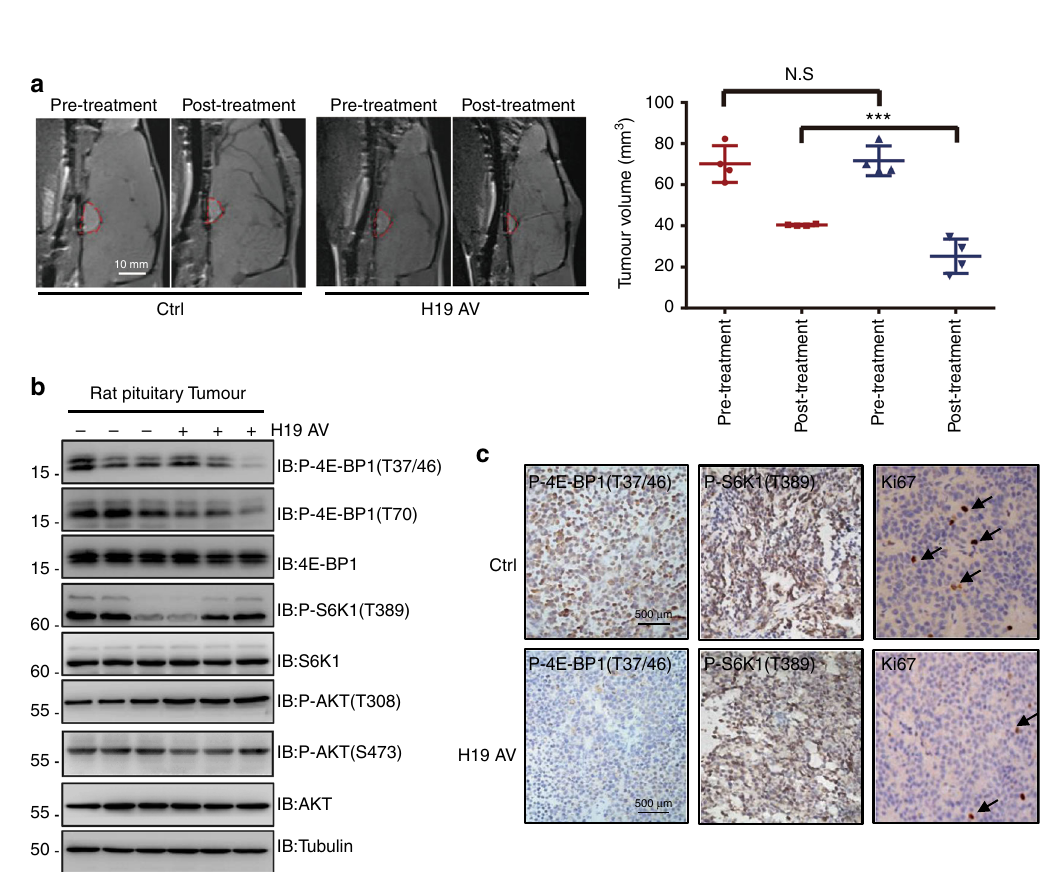
Fig. 6 H19 suppresses oestrogen-induced rat pituitary tumour tumourigenesis. a H19 adenovirus has therapeutic effects on rat in situ prolactinomas. When prolactinomas were induced by 17 β -estradiol for 6 weeks, tumour-bearing rats were treated with one stereotactic intratumoural injection of 10 9 pfu adenovirus harbouring the H19 overexpression construct or the control EV. Two weeks later, tumour size was measured by MRI; tumours were then dissected, and tumour volume was calculated. The data are presented as the mean ± SEM (red circles, n = 4; *** p < 0.001), scale bar,1 cm. b Overexpression of H19 suppresses 4E-BP1 phosphorylation in rat in situ prolactinomas. Some of the dissected tumour tissues described in a were homogenized in lysis buffer with a tissue homogenizer; then, the samples were centrifuged, and the supernatant was collected and used for immunoblot analysis with the indicated antibodies. c Representative images of IHC staining show that H19 administration decreases 4E-BP1 phosphorylation, but not S6K1 phosphorylation, and pituitary tumour cell proliferation (Ki-67), scale bar, 500 μ m